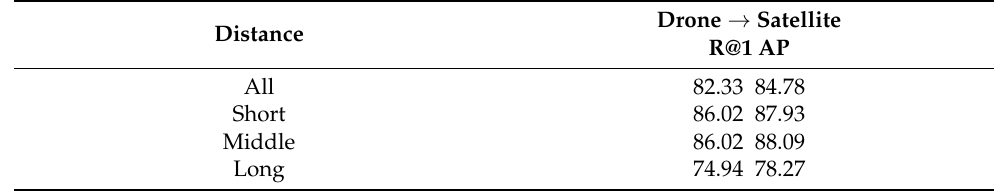
Figure 7. ( a ) Effect of shifting in query images. ( b ) Effect of distance to geographic target in query images. Table 5. Results of ablation experiments of using drone images with different distance to geographic target to conduct retrieval. “All” stands for using all drone-views query